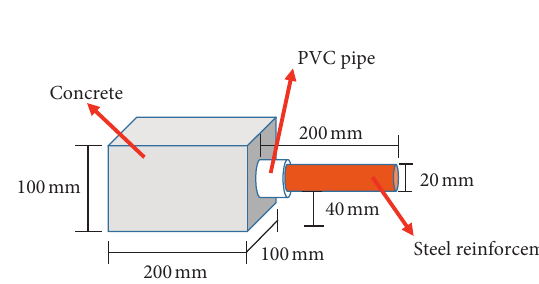
Figure 1: Details of stereoscopic